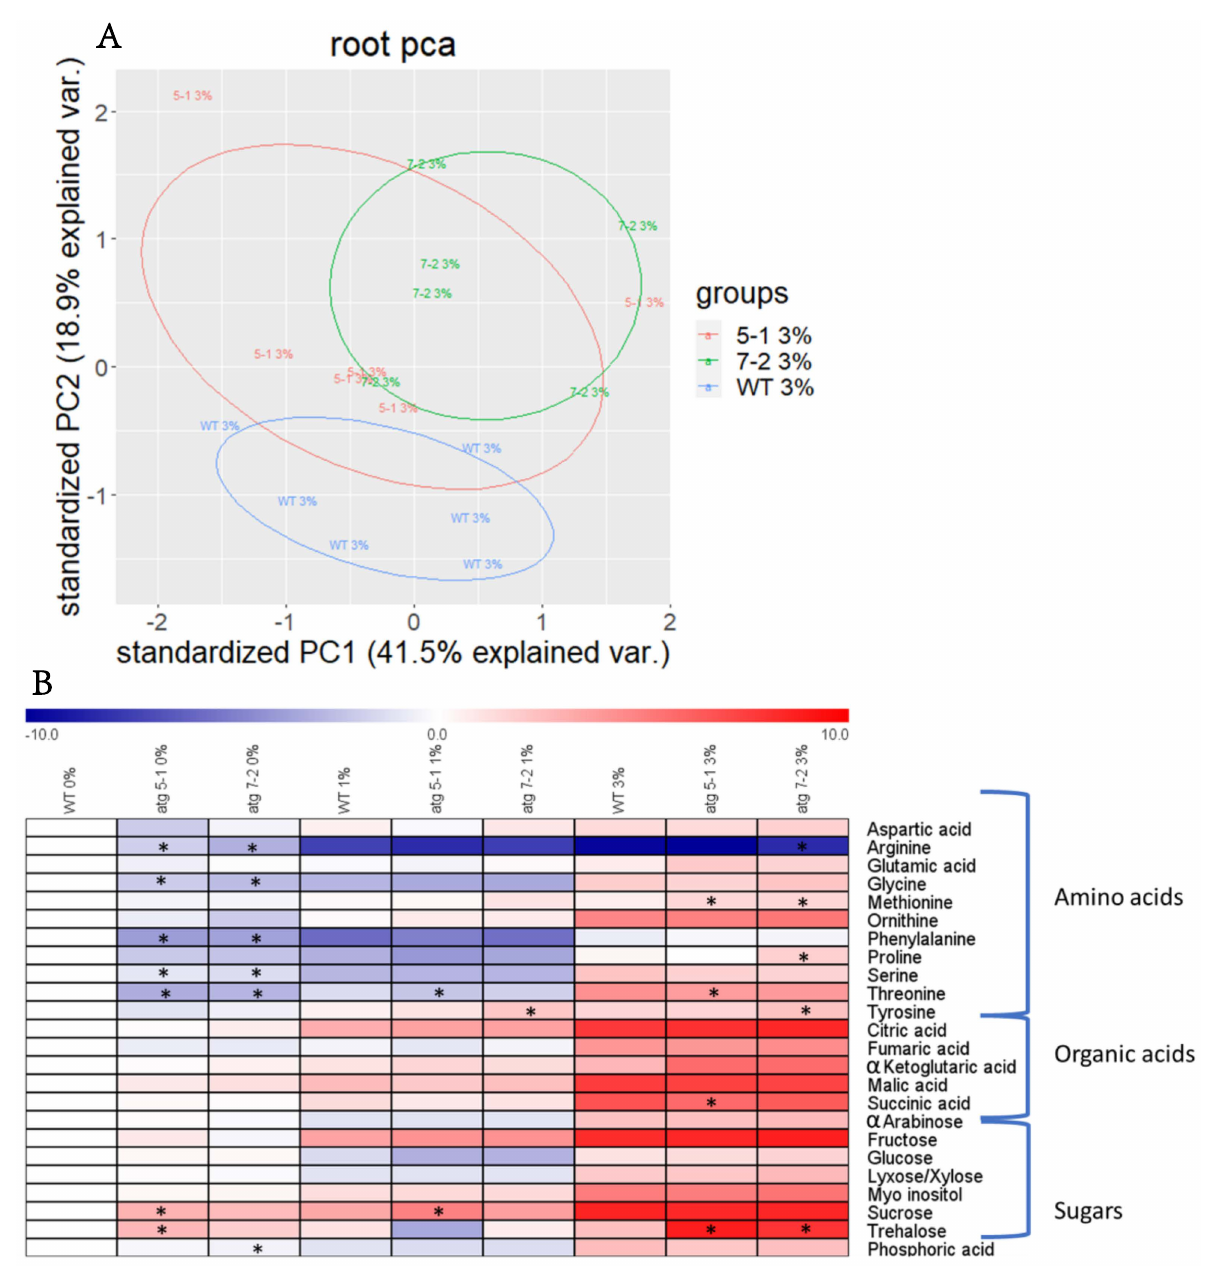
Figure 5. Sucrose excess affects the root metabolome, but the influence of autophagy on the response is mild. Roots from WT, atg5-1 , and atg7-2 seedlings grown for 10 days under various sucrose concen- trations were collected, and polar metabolites were extracted and analyzed by gas-chromatography mass-spectrometry (GC-MS) ( A ). Principal component analysis (PCA) performed on scaled values of metabolites measured in roots grown under 3% sucrose ( B ). Heatmap displaying the relative amounts of root metabolites under various sucrose concentrations. Results are presented as the log2 ratio normalized to WT under 0% sucrose. An asterisk denotes a significant difference from WT under the same treatment regimen, as determined by Dunnett’s test ( p < 0.05, n =